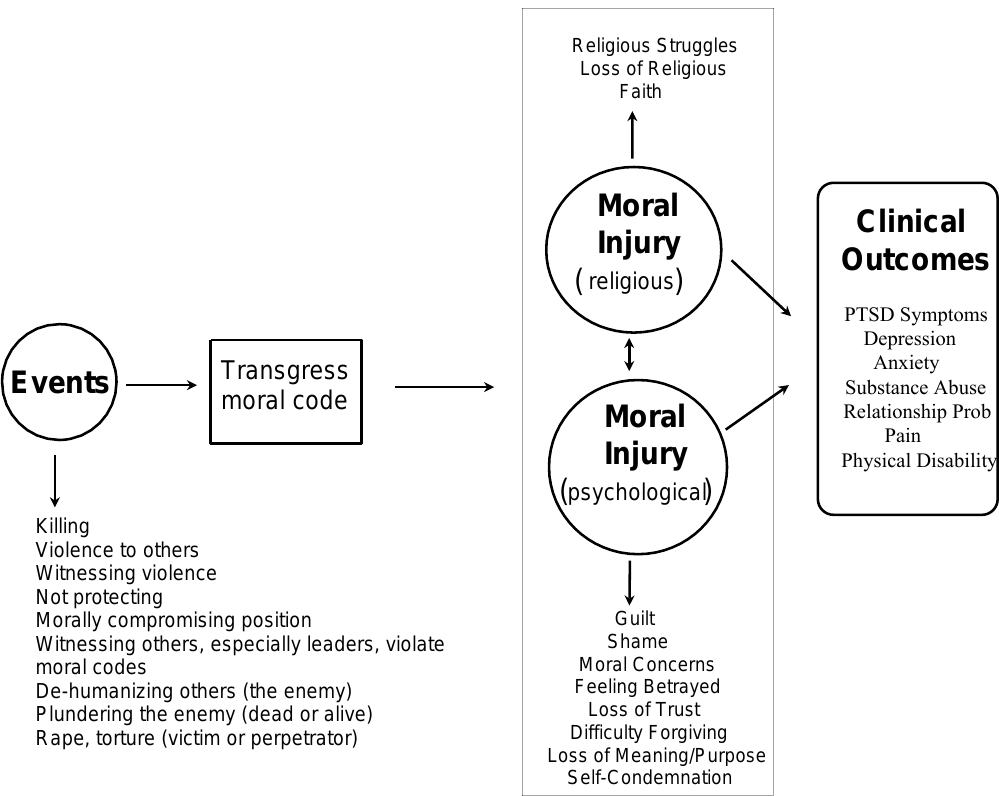
Figure 1. Illustration of the relationship between traumatic events, moral injury, PTSD and comorbid psychological, social, behavioral, and physical outcomes (adapted from Koenig et al. (2017), used with permission).